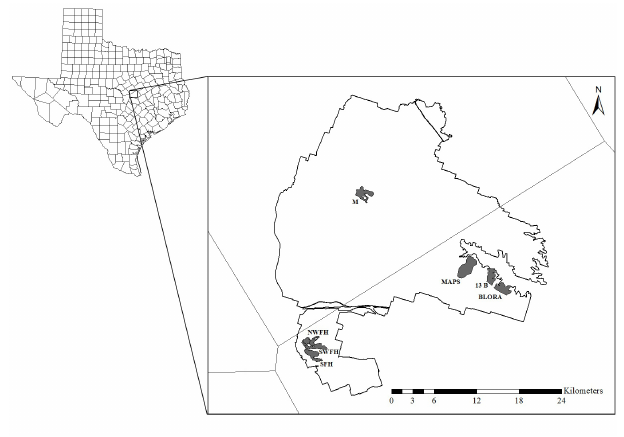
Fig. 1 . Map of the Fort Hood Military Reservation, Texas, USA, and study plots where Golden-cheeked Warbler ( Setophaga chrysoparia ) capture-resight programs occurred for at least three years. 13 B is Thirteen B, BLORA is Belton Lake Outdoor Recreation Area, SFH is South Fort Hood, M is Manning, NWFH is North West Fort Hood, SWFH is South West Fort Hood, and MAPS is Monitoring Avian Productivity and